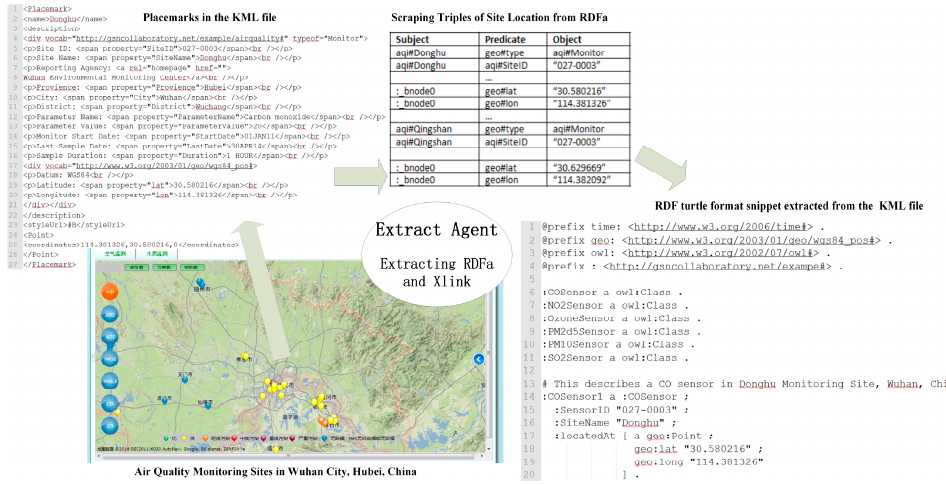
Figure 7. Extract Agent.